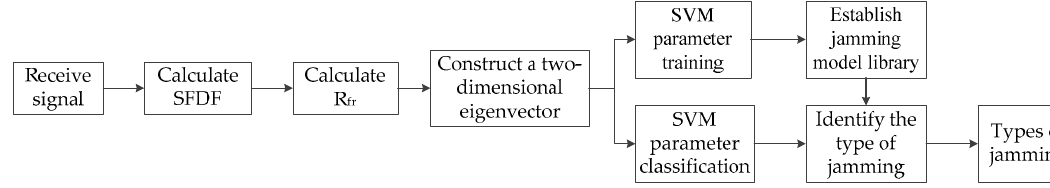
Figure 5. Block diagram of interference recognition based on two-dimensional features.